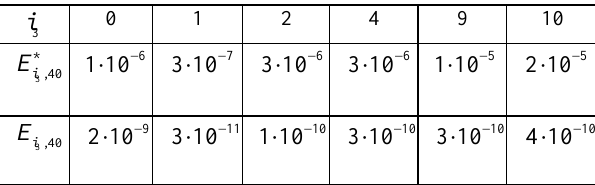
I and error 3 ,40 i